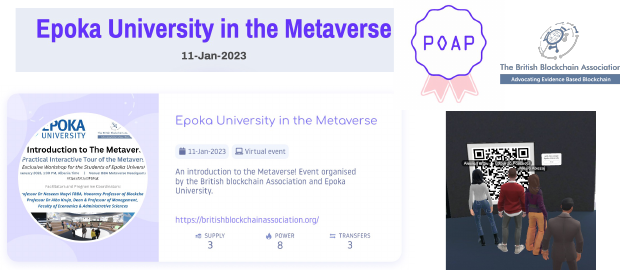
Figure 20: POAP NFTs in the Metaverse for Attendees